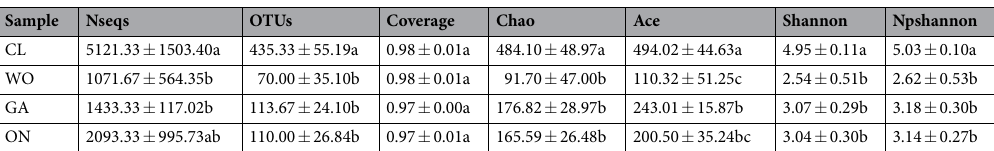
Table 2. Microbial community richness and diversity indices of the four Allium species at a 97% similarity threshold. Note: Nseqs, number of sequences analyzed; OTU, operational taxonomical unit; ACE, abundance- based coverage estimator. Values are means ± standard error (n = 3). Different letters indicate statistically significant differences at the 0.05 probability level according to Fisher’s least significant difference (LSD) test. CL: Chinese leek; WO: Welsh onion; GA: Garlic; ON: onion.